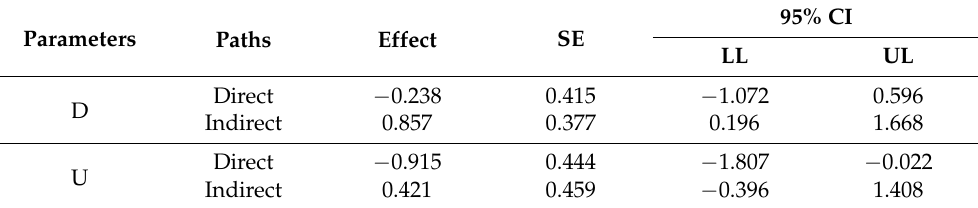
Table 3. Mediation analysis of emotional valence between stress and moral